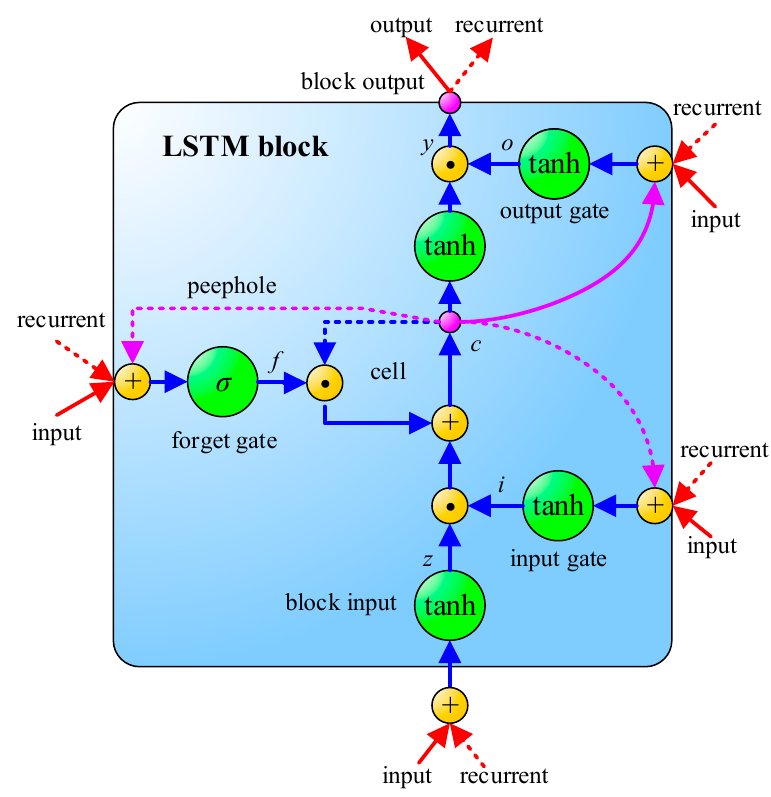
Figure 4. The schematic of Long Short-Term Memory (LSTM) [24].